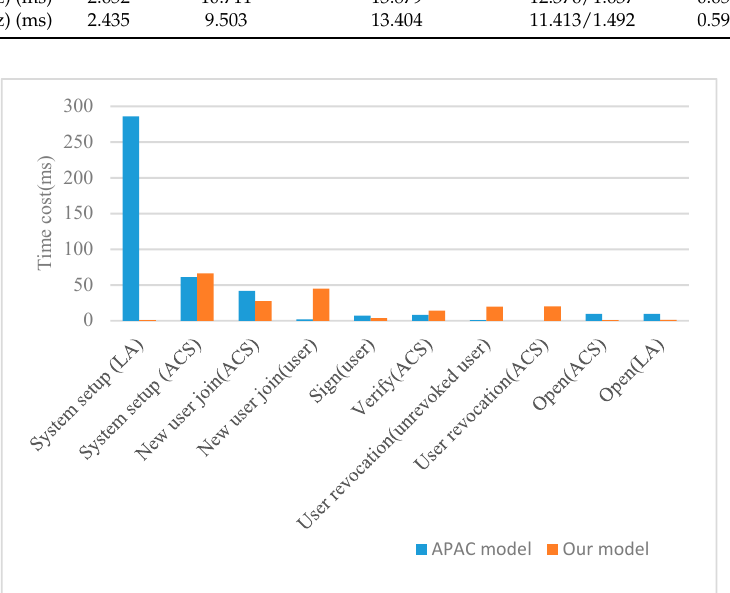
Figure 11. Comparison between the APAC model and our privacy-preserving framework in the time cost.